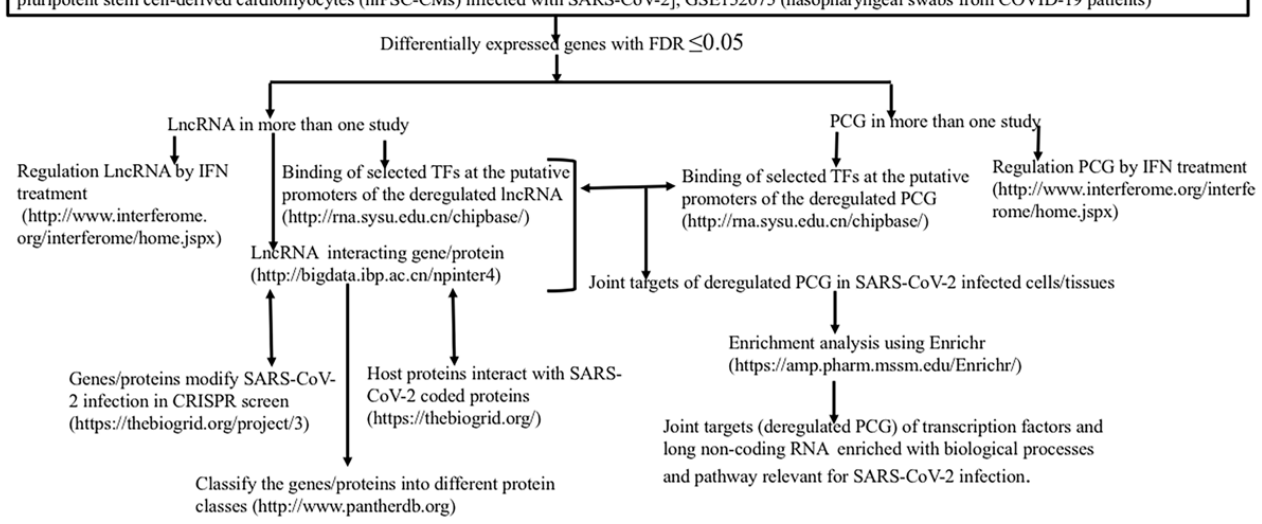
Figure 1. The overall flow diagram is followed in the manuscript. To find out the transcription factors (TFs), especially IFR1-IFR5, IRF8, IRF9, STAT1-STAT4, STA5A, STAT6, NFKB1, NFKB2 and RELA/p65 (for justification for the choice please see Section 2.3) that might regulate the expression of the genes, we searched ChIPBase database. Similarly, the Interferome database was used to find out whether genes could be regulated by IFNs. Interacting partners of deregulated lncRNA obtained from NPInter v4.0 were further used for identifying the functional role of the genes/proteins in SARS-CoV-2 infection from BioGRID and PANTHER. To identify the common targets of TFs and deregulated lncRNA, we compared (shown as a double headed arrow) lncRNA interacting gene/protein and deregulated PCGs that were targets of common TFs. Finally the enrichment of the common targets of TFs and lncRNA using Enrichr for functional annotation of the co-regulated targets. IP addresses used are included. For details please see the text.